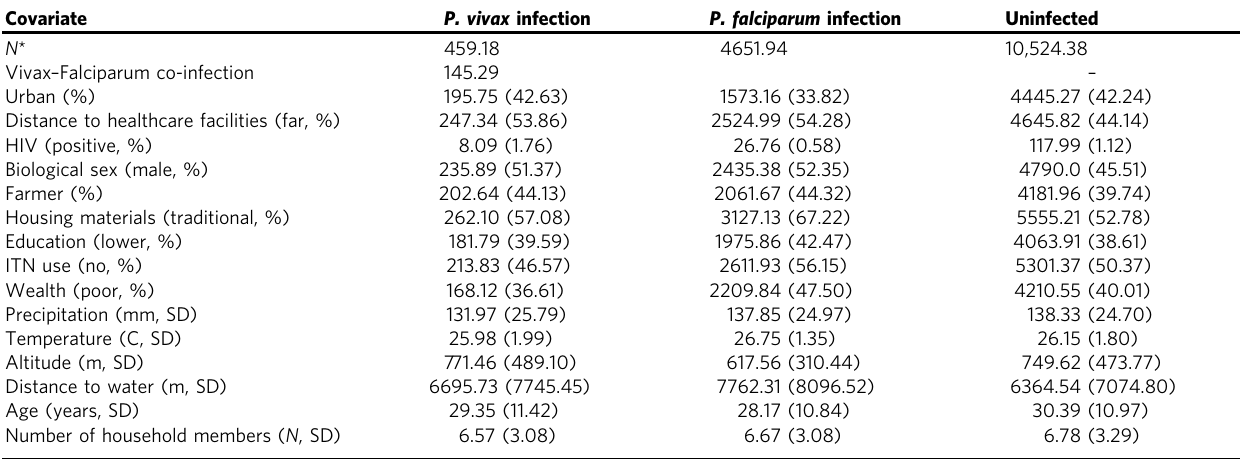
For dichotomized risk factors, the weighted counts and weighted percentages for each category are provided. For continuous risk factors, the mean and standard deviation (SD) are provided. N number of individuals, mm millimeters, m meters, ITN insecticide-treated net. * Co-infections are included for both the P. vivax and P. falciparum marginal infection